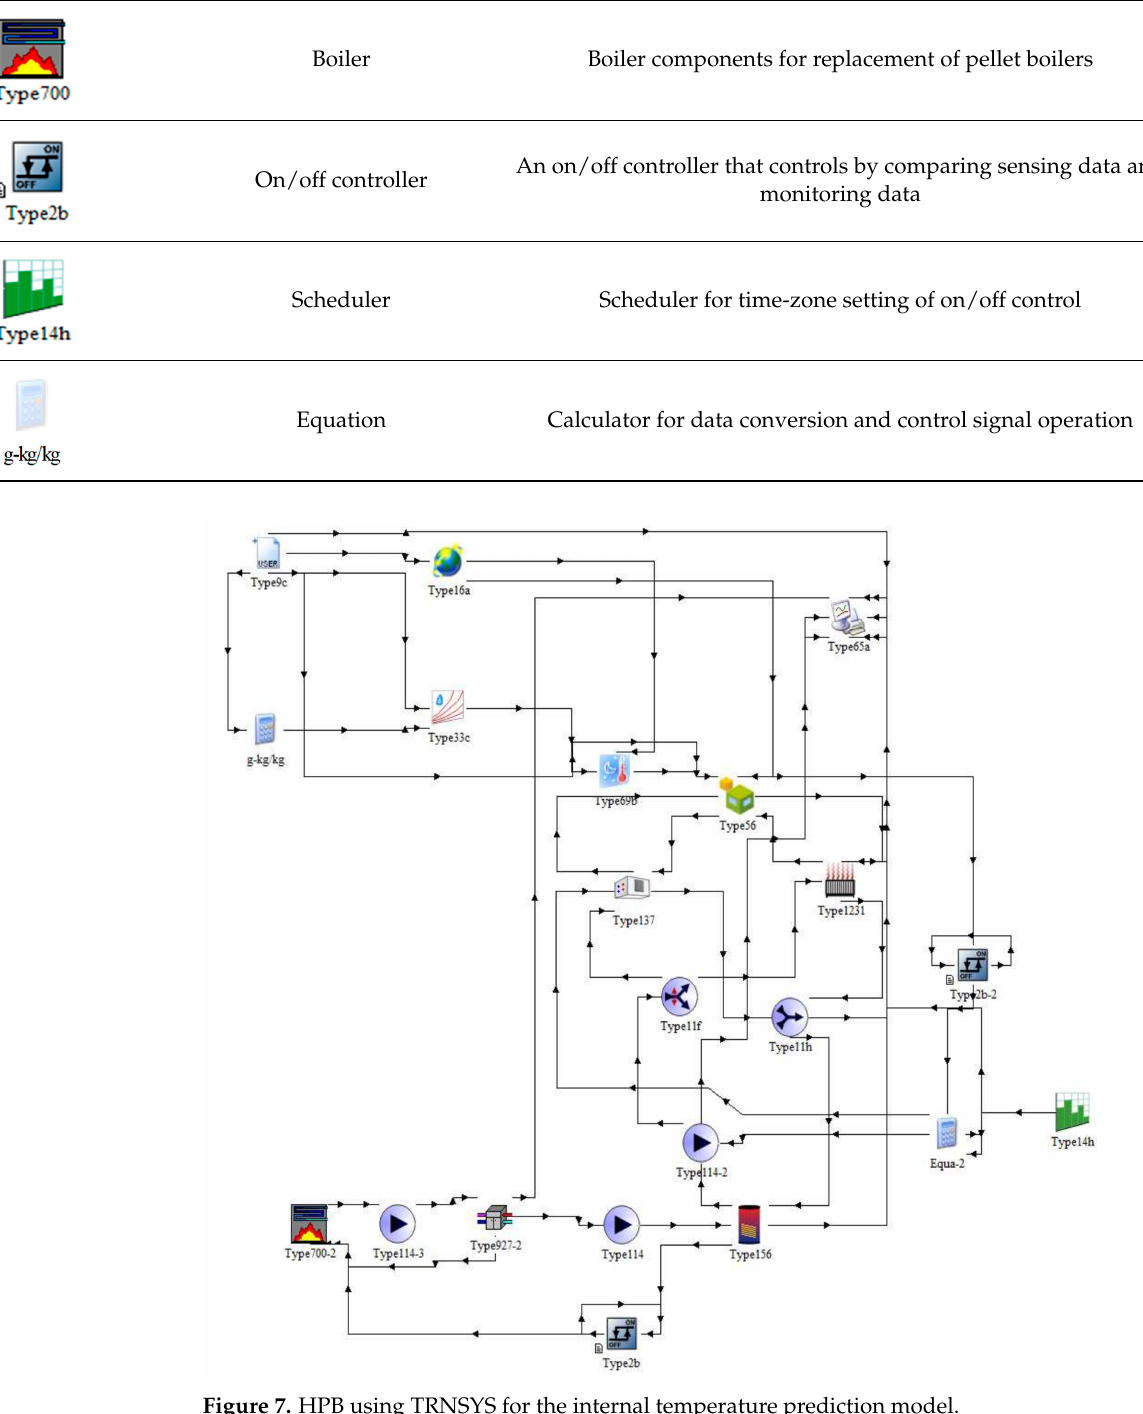
Figure 7. HPB using TRNSYS for the internal temperature prediction